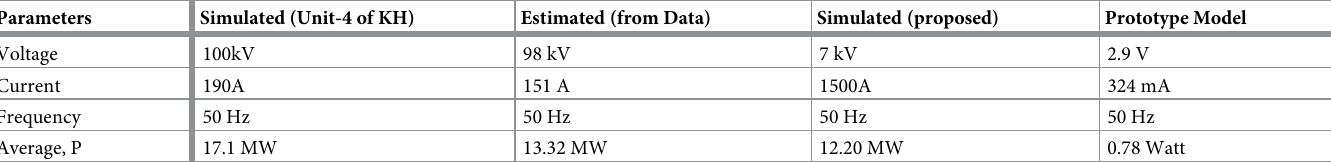
Table 4. A comparison among estimated, simulated and experimental